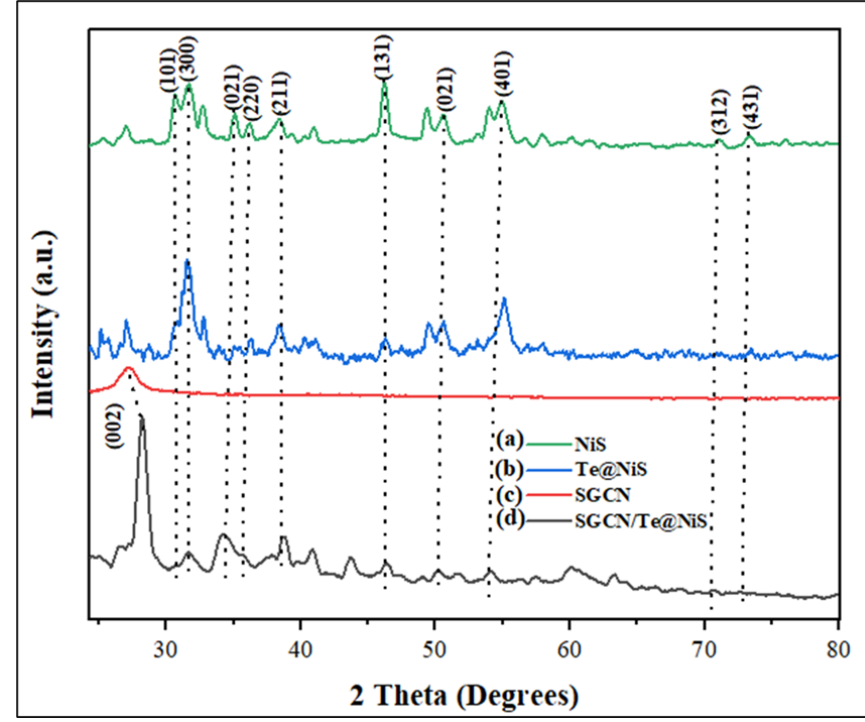
Figure 3. XRD pattern of ( a ) NiS, ( b ) Te@NiS, ( c ) SGCN, and ( d ) SGCN/Te@NiS.